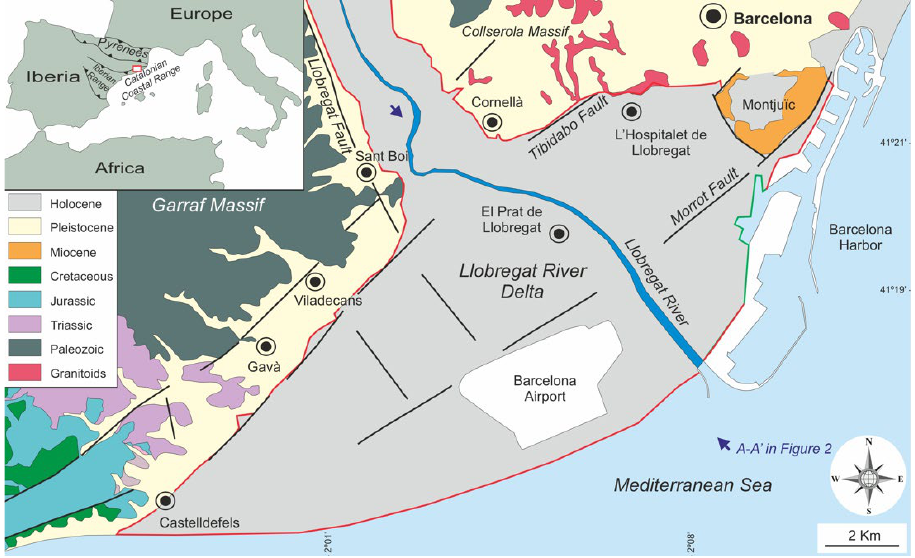
Figure 1. Geological sketch map of the onshore LRD area (green line contour), modified and simplified from Medialdea and Solé-Sabarís [17,18], Alonso et al. [19], and Gámez et al. [20]. Geological cross-section A-A’ is displayed in Figure 2.